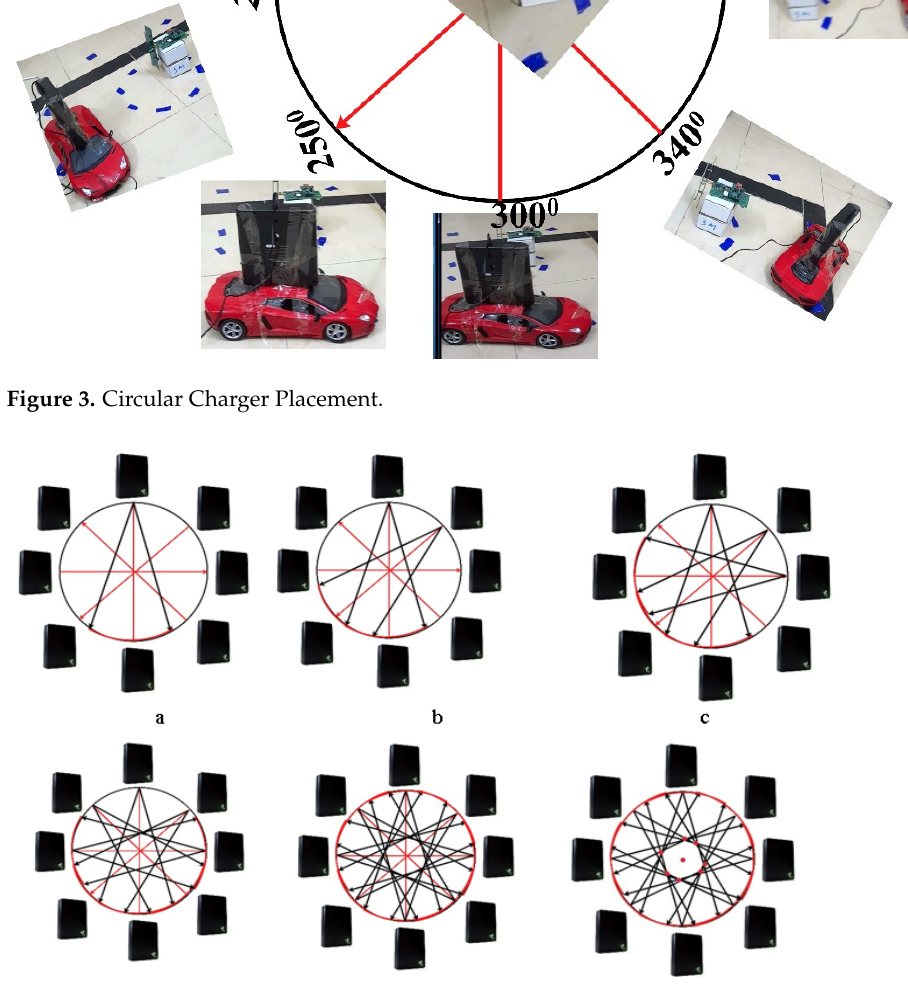
Figure 4. Optimal Points Algorithm Phases.